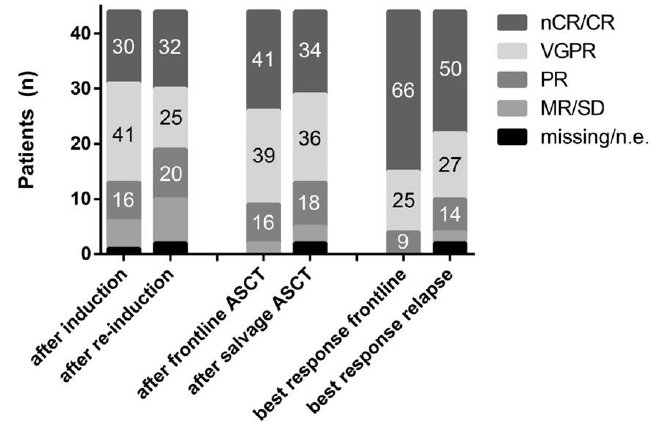
Figure 1. Depth of response after (re-)induction, frontline/salvage HDCT/ASCT, and at best response.